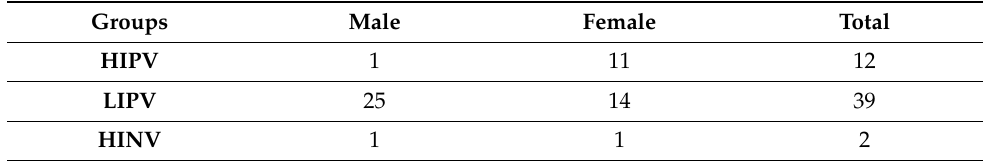
Table 4. The gender distributions between the